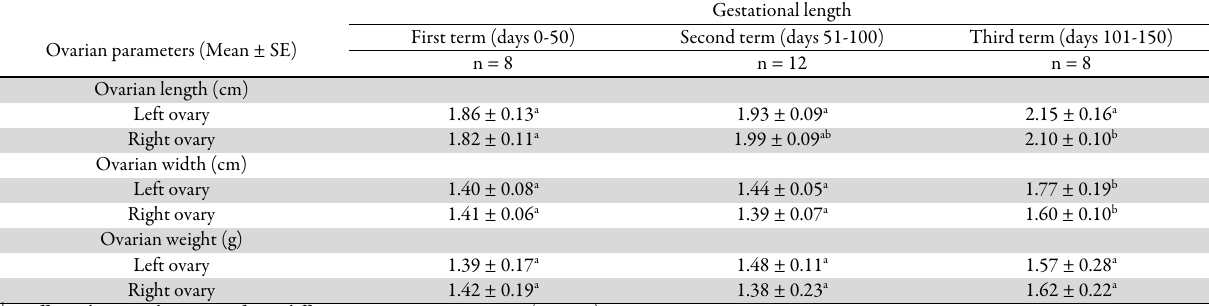
Table 4.The mean placentomal biometrics of Maradi doe goats per term gestation